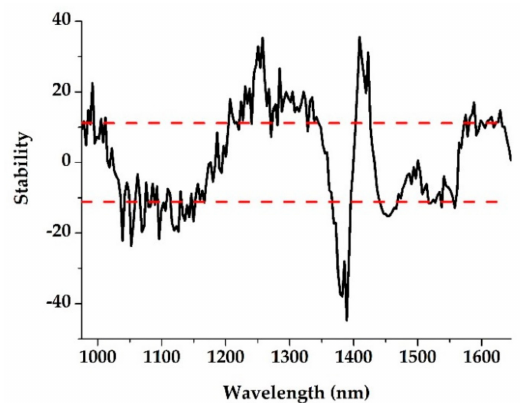
Figure 3. The stability distribution of TN using uninformative variable elimination